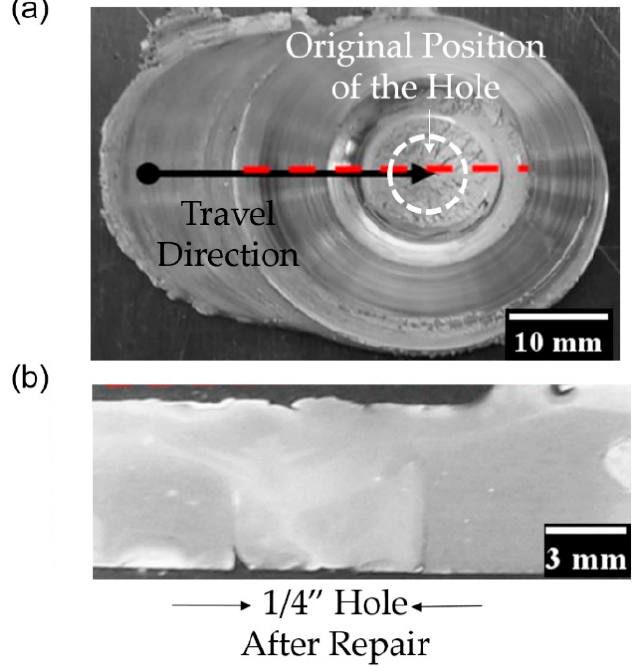
Figure 5. ( a ) Top-down view of the completed deposition for the hole fill sample with the tool traverse marked; ( b ) cross-sectional view of hole fill sample taken at the red dotted-line.